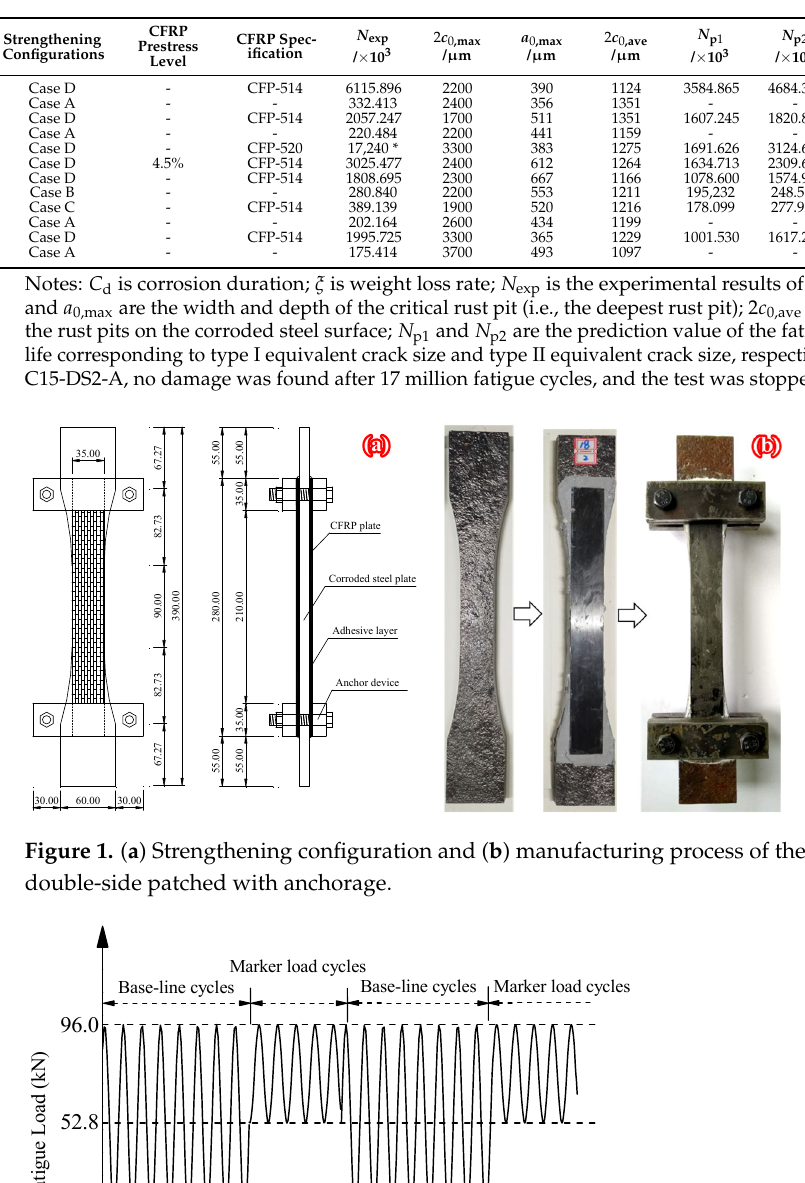
Table 2. Results summary of the fatigue test and fatigue crack propagation prediction.